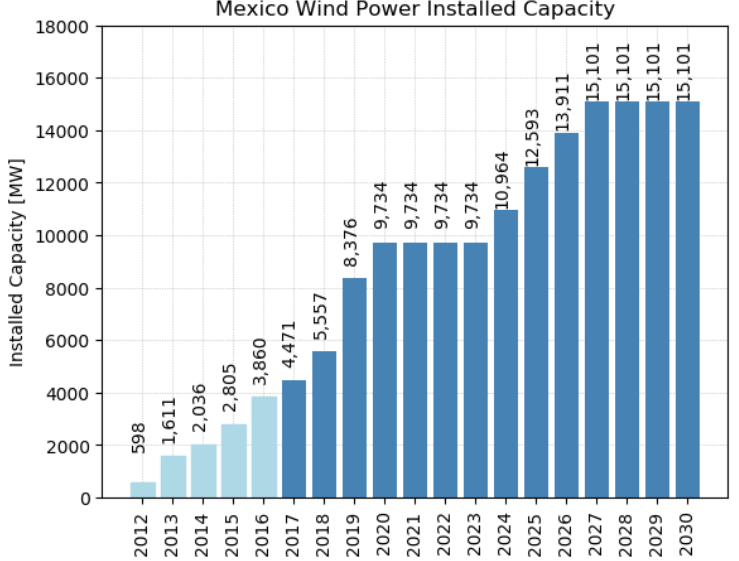
Figure 1. Wind power installed capacity over the years in Mexico. Light blue represents current information, and dark blue indicates the Mexican government’s projection from 2019 to 2030. The goal is to reach 15,101 MW in 2030, which translates to installing approximately 4 times the 2016 installed